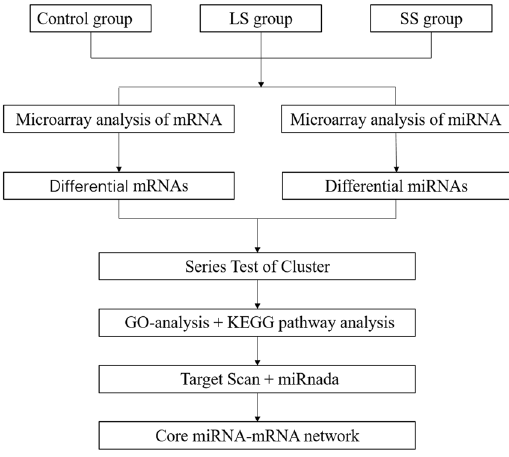
Figure 1. Flow chart of constructing the miRNA-mRNA network associated with selenium deficiency. LS, low selenium; SS, selenium supplementation; GO-analysis, Gene Ontology analysis; KEGG pathway analysis, Kyoto Encyclopedia of Genes and Genomes pathway analysis.